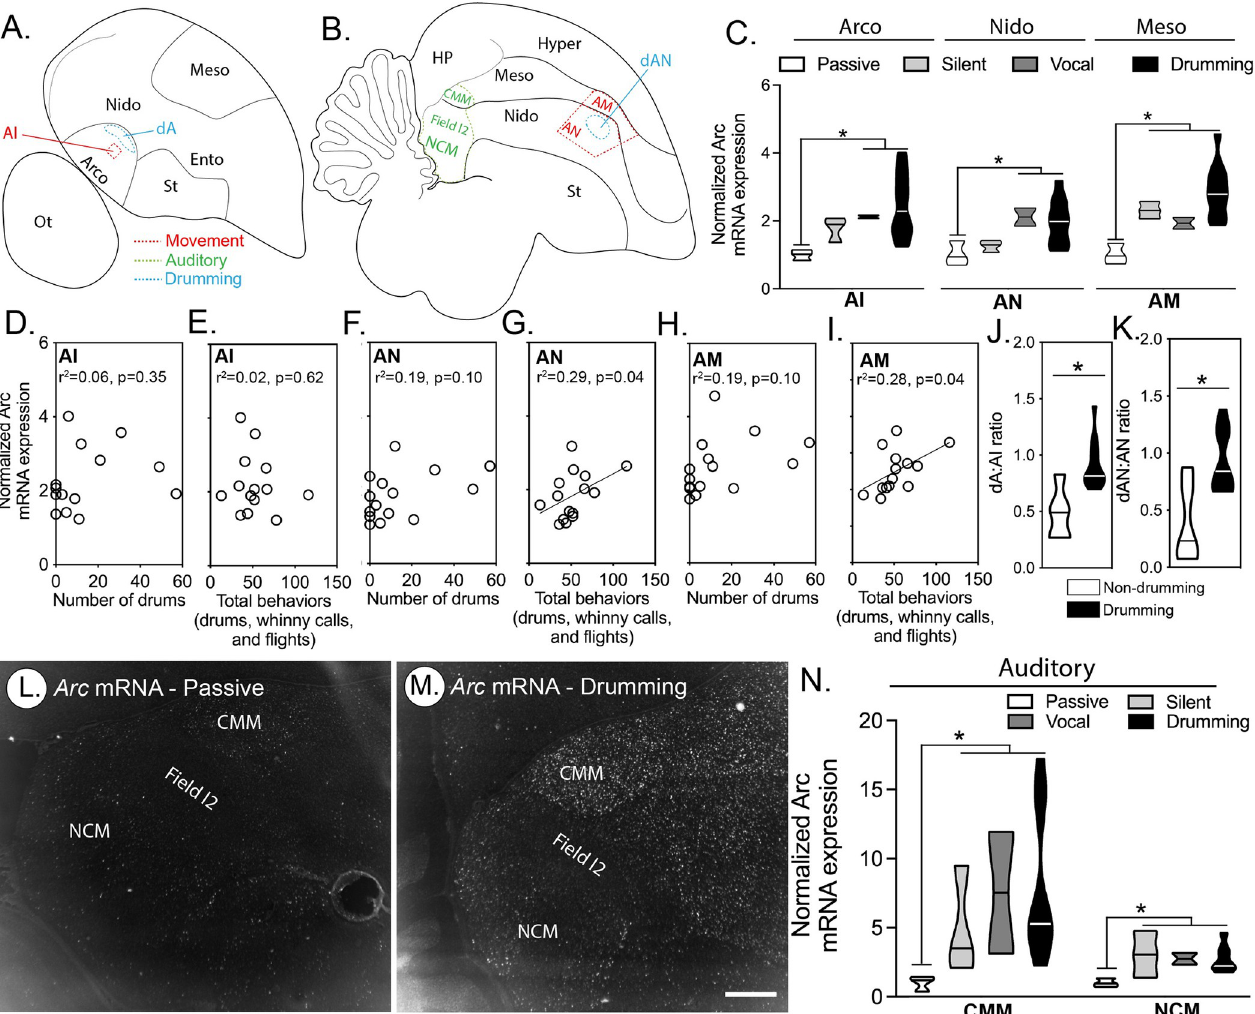
Fig 7. Movement and hearing-induced IEG expression in telencephalic regions of woodpeckers. (A-B) Schematic diagrams of sagittal brain sections for (A) lateral and (B) medial brain nuclei. (C) Violin plots (horizontal line denotes group median) illustrating significant differences in Arc mRNA expression in 3 movement related brain regions (AI: F 3 , 14 = 3.99, p = 0.03, AN: F 3 , 14 = 3.83, p = 0.03, AM: F 3 , 14 = 10.50, p < 0.001) in male downy woodpeckers caught after hearing playbacks of drumming during simulated territorial intrusions (STIs) and either being silent in response or producing different behaviors. (D-I) No correlation was detected with the total number of drums and Arc expression in the (D) AI, (F) AN, or (H) AM (all p -values > 0.05). No correlation was detected between the total number of measured behaviors (drums, whinny calls, and flights) produced during the STI and Arc expression in the (E) AI ( p > 0.05), but significant positive correlations were detected in the (G) AN and (I) AM (both p -values < 0.05). Significant correlations have solid lines ( p < 0.05). (J and K) Violin plots (horizontal line denotes group median) illustrating the ratio of Arc mRNA in putative drumming nuclei (e.g., dA (t 13 = 3.10, p < 0.01) or dAN (t 13 = 3.73, p < 0.01)) relative to the surrounding brain region (i.e., (J) AI or (K) AN, respectively). (L and M) Representative in situ hybridization microscope images of Arc expression (white) with fast red as a counterstain (grey) in a downy woodpecker that was (L) passively caught or (m) a bird that drummed while listening to a drumming playback during the STI. (N) Violin plots (horizontal line denotes group median) illustrating significant differences in Arc mRNA expression in 2 auditory forebrain nuclei (CMM: F 3 , 13 = 4.91, p = 0.02; NCM: F 3 , 13 = 4.05, p = 0.03) of downy woodpeckers caught after hearing playbacks of drumming and either being silent in response or producing different behaviors. Data for C-K and N can be found in S2